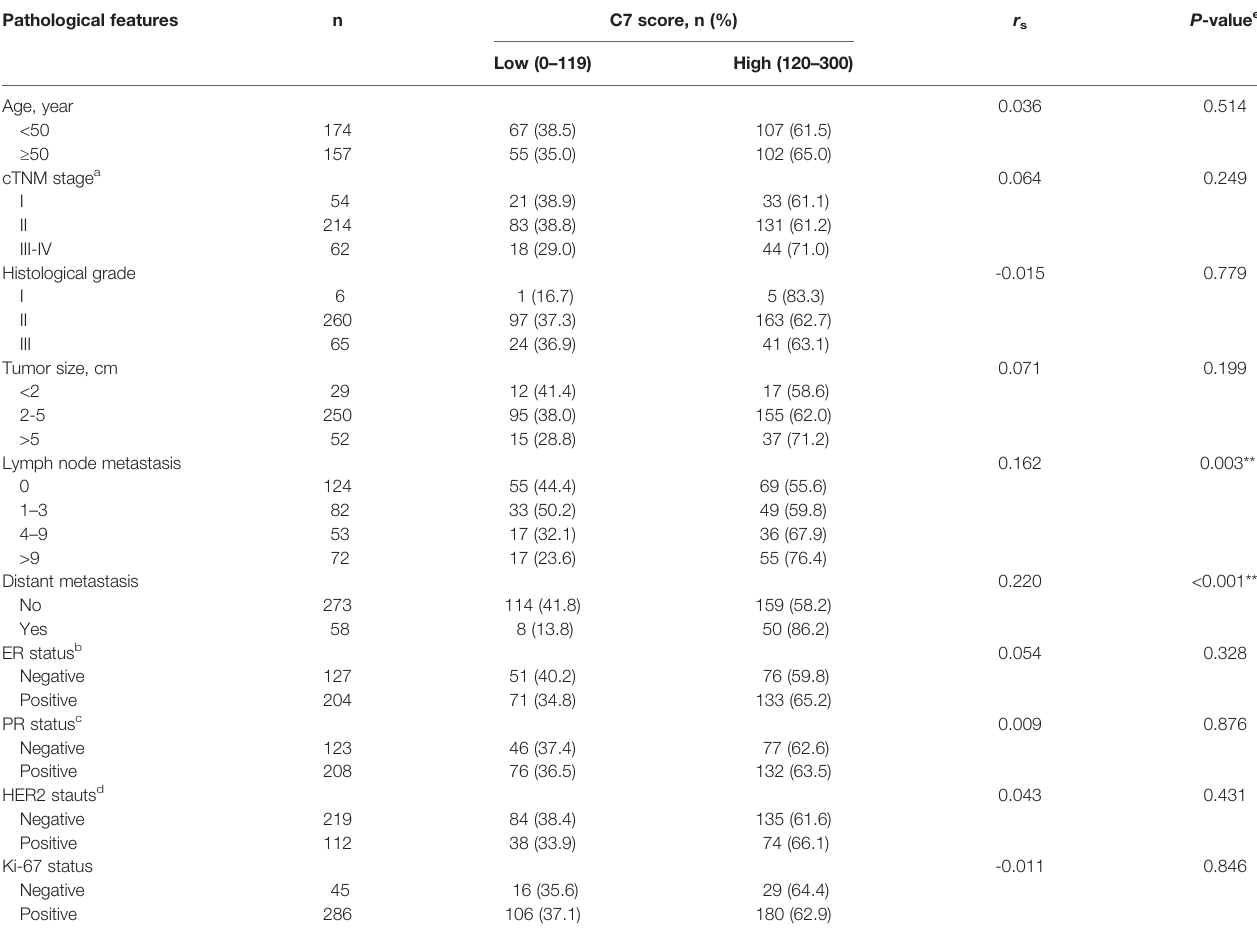
TABLE 2 | C7 expression and pathological features of IDC patients. Pathological